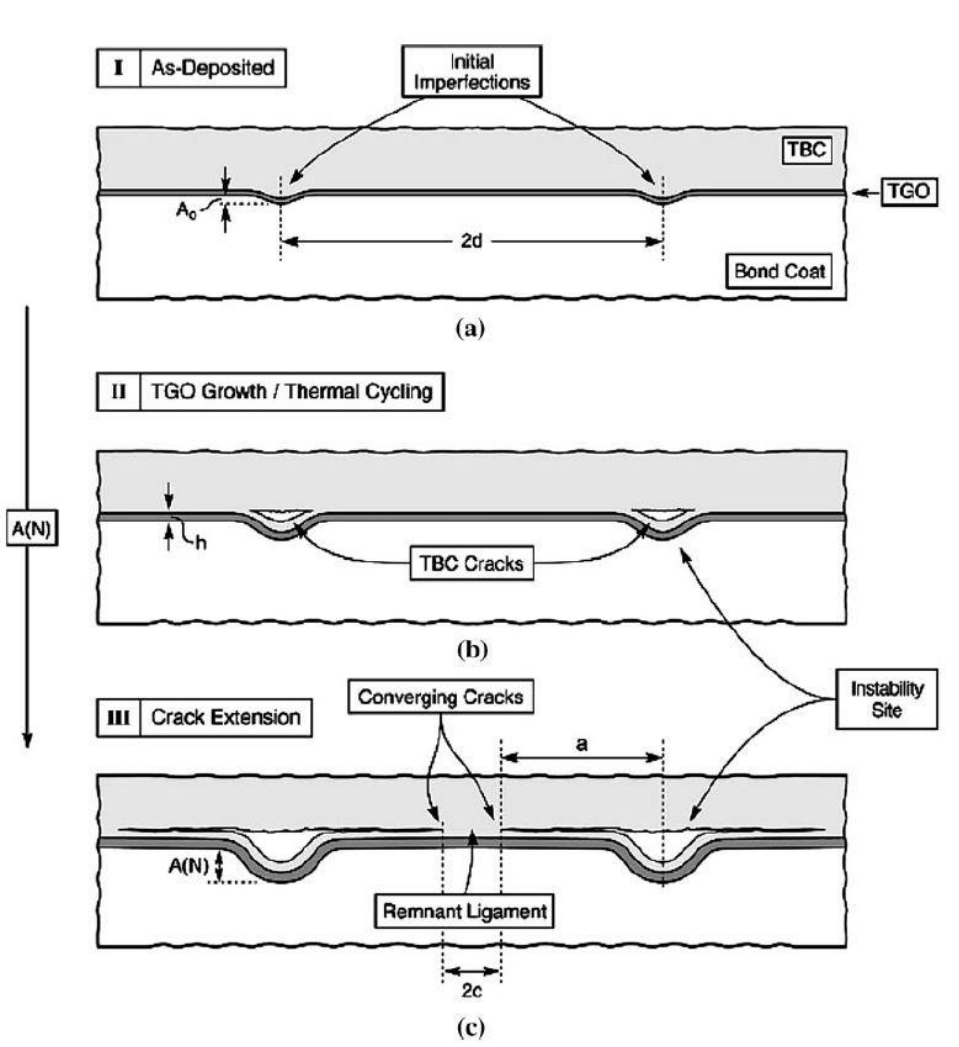
Figure 38. Failure of an EB-PVD TBC system driven by a cyclic instability in the thermally grown oxide layer [18]. ( a ) Interfacial roughening at stage of as-deposited ( b ) Crack initiation as TGO grwoth ( c ) The propagation of interfacial cracks.